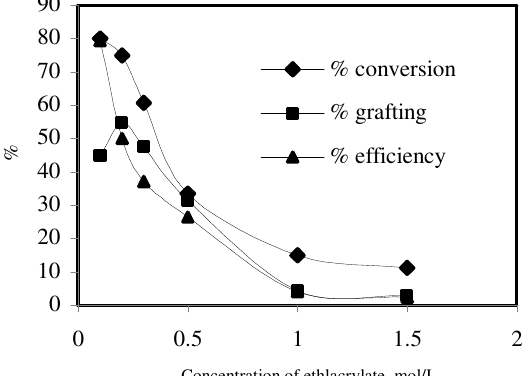
Figure 2. Influence of concentration of the ethyl acrylate on the grafting of unbleached fibres